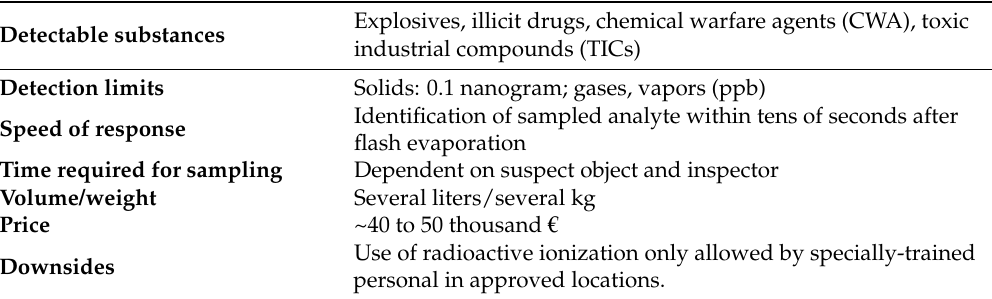
Table 4. Properties of state-of-the-art IMS instruments.